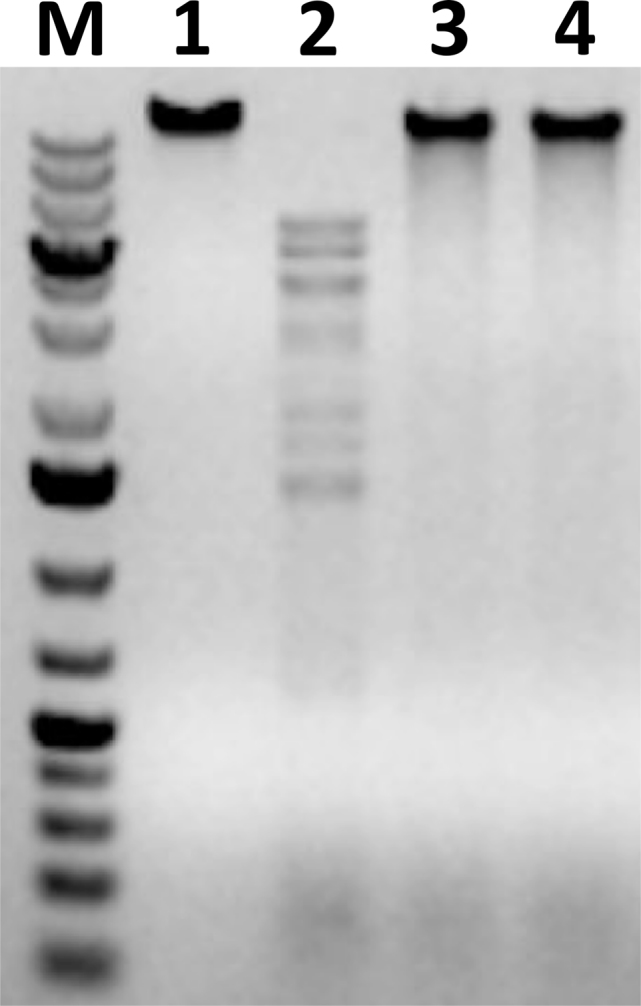
BREX+ cells extracts lack nuclease activity under conditions when restriction-endonuclease activity is detected. Cell extracts prepared from Escherichia coli cells harboring a plasmid containing EcoRV restriction-modification system genes (lane 2), pBREXAL plasmid (lane 3) or pBTB-2 control vector (lane 4) were combined with unmodified λ phage DNA, incubated and reaction products were resolved by agarose gel electrophoresis. Lane 1 is a control lane, phage genome incubated with buffer. M is a molecular weight marker.